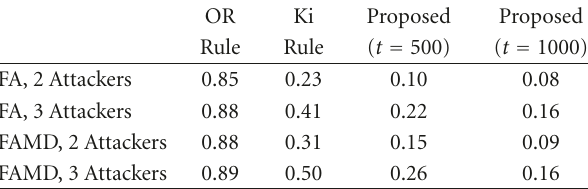
Figure 4: ROC curves for di ff erent collaborative sensing schemes ( P a = 100%, False Alarm & Miss Detection Attack). Table 2: False Alarm Rate (when detection rate =